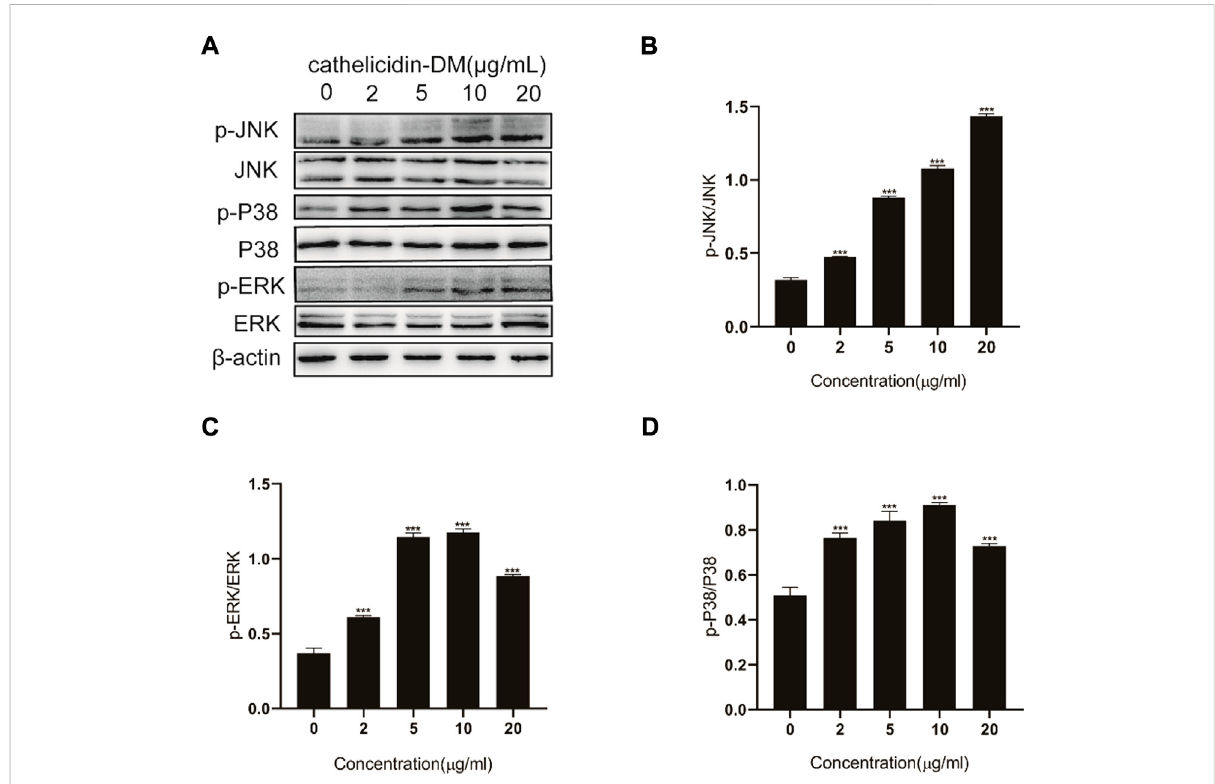
FIGURE 3 Effect of cathelicidin-DM on MAPK signaling pathway. (A) Western blot demonstrates the effect of cathelicidin-DM on the phosphorylation of JNK,ERK,andP38. (B – D) RelativegreyscaleanalysisbyImageJandrelativeactivationbycathelicidin-DMofJNK (B) ,ERK (C) ,andP38 (D) expression. Values for the cathelicidin-DM treated group were signi fi cantly different from control groups. * p < 0.05, ** p < 0.01 ( n =